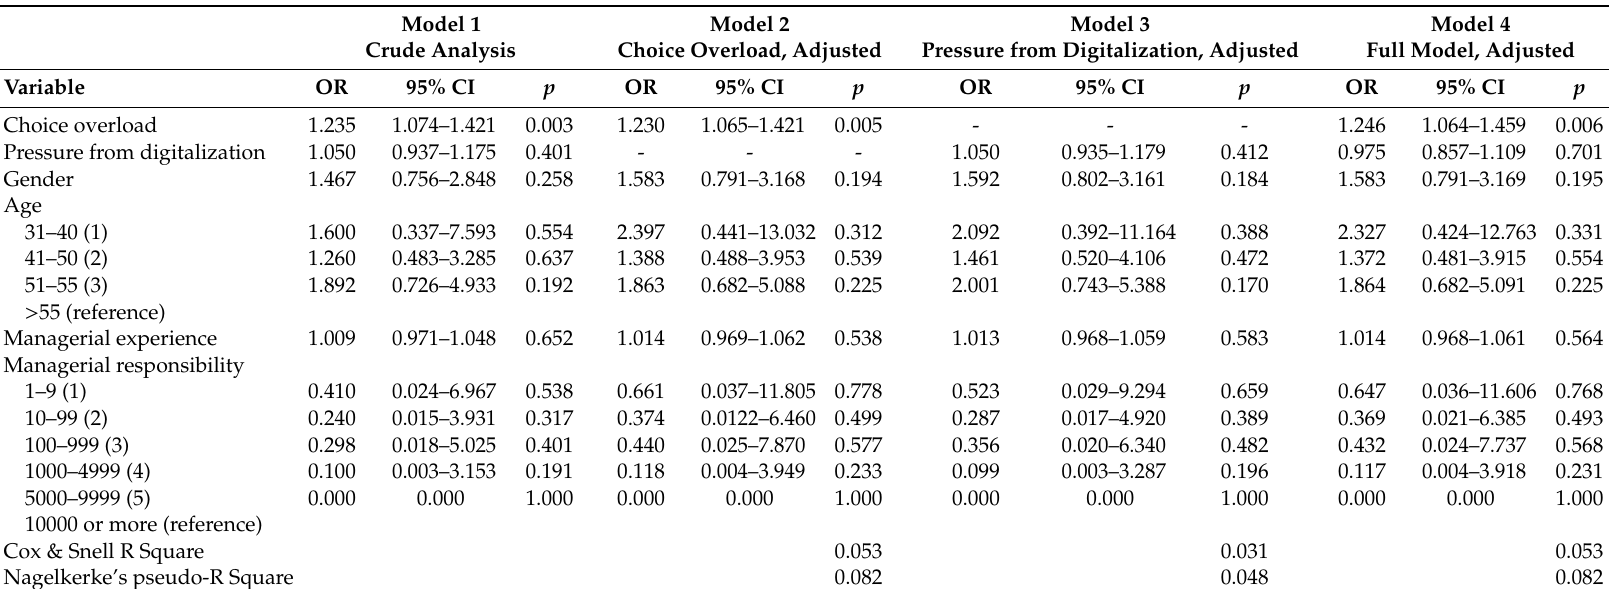
Table 3. Results of the stepwise Logistic Regression